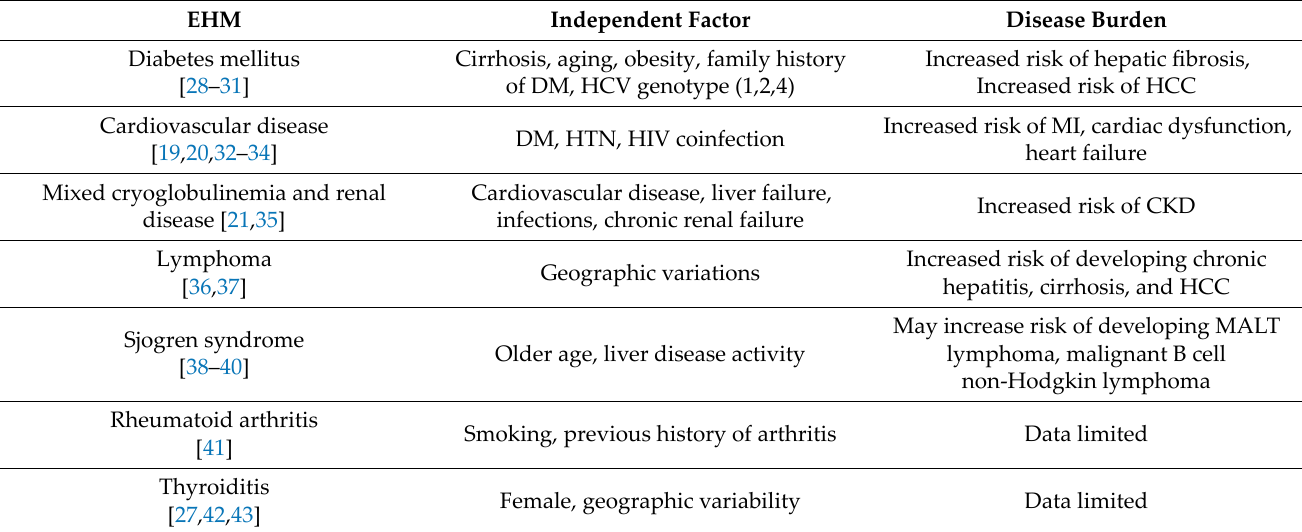
Table 2. Independent factors and disease burdens of